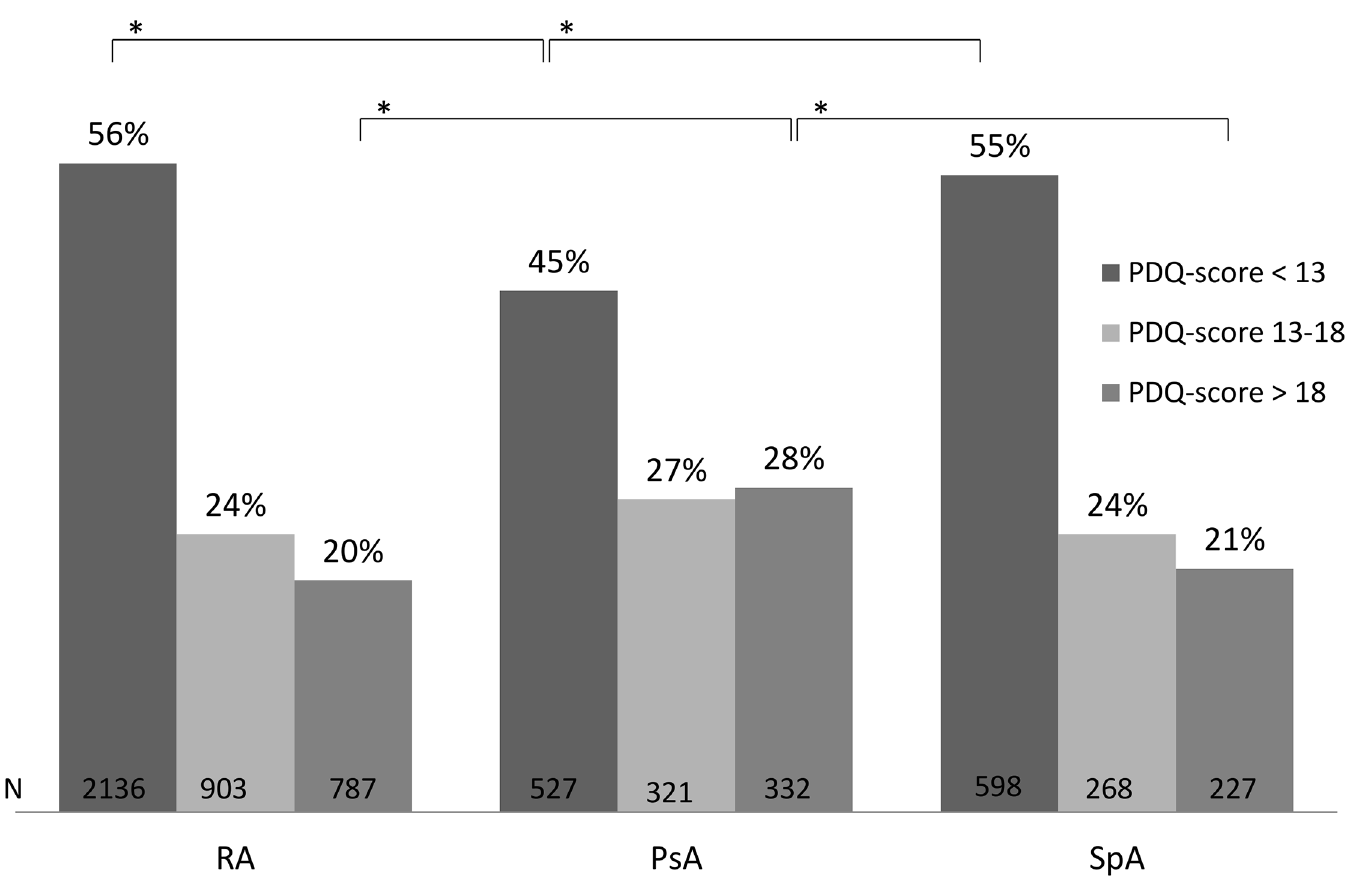
Fig 2. Distribution of painDETECT classification-groups ( < 13/ 13-18/ > 18). * p < 0.001.